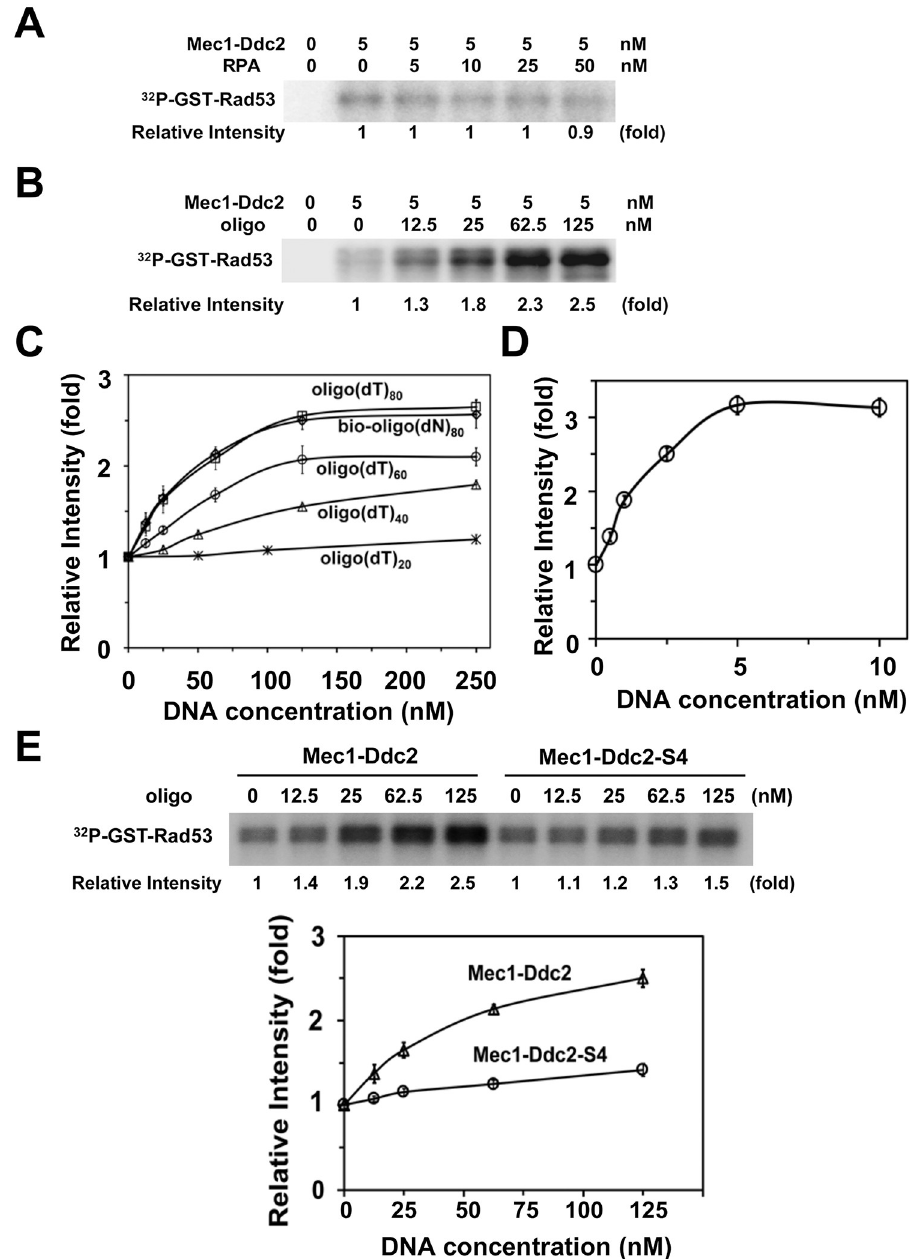
Fig 6. Effect of RPA or ssDNA addition on Mec1 activity. (A) Effect of RPA addition on Mec1 catalytic activity. Kinase reactions were carried out with or without Mec1-Ddc2 (5 nM) using various concentrations of RPA. GST-Rad53 C-terminus fusion (GST-Rad53) was used as a substrate of Mec1. Incorporation of 32 P into GST-Rad53 was detected by phosphor imaging. The Rad53 C-terminus does not contain its kinase domain; phosphorylation of GST-Rad53 depends on Mec1-Ddc2. Phosphorylation levels of GST-Rad53 were normalized to that observed with Mec1-Ddc2 alone. The error bars indicate standard deviation from three independent experiments. (B) Effect of ssDNA addition on Mec1 catalytic activity. Kinase reactions were carried out with or without Mec1-Ddc2 (5 nM) using various concentrations of 80-mer biotin-oligo(dN) 80 . Incorporation of 32 P into GST-Rad53 was analyzed as in A. The error bars indicate standard deviation from three independent experiments. (C, D) Effect of length and base-composition of ssDNA on Mec1 activation. Mec1-Ddc2 complex (5 nM) was incubated with various concentrations of oligonucleotides (20, 40, 60, 80-mer oligo(dT), 80-mer bio-oligo(dN) 80 (C) or F X phage ssDNA (5 kb) (D). Phosphorylation of GST-Rad53 was normalized to that observed without RPA or ssDNA. The error bars indicate standard deviation from three independent experiments. (E) Effect of ddc2-S4 mutation on Mec1